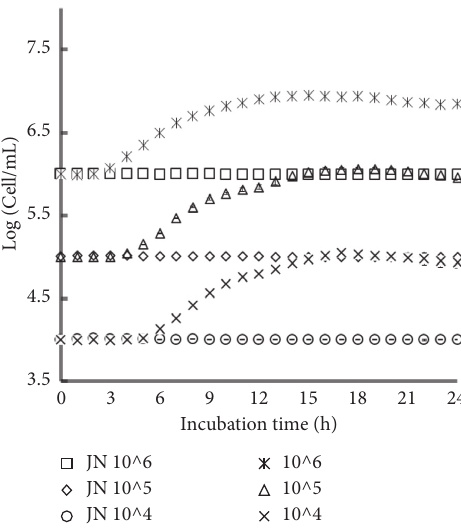
Figure 1: Growth kinetics of Escherichia coli O157: H7 at initial concentrations of 10 4 , 10 5 , and 10 6 cells/mL in the presence or absence of NJ, monitored for 24h at 37 ° C.